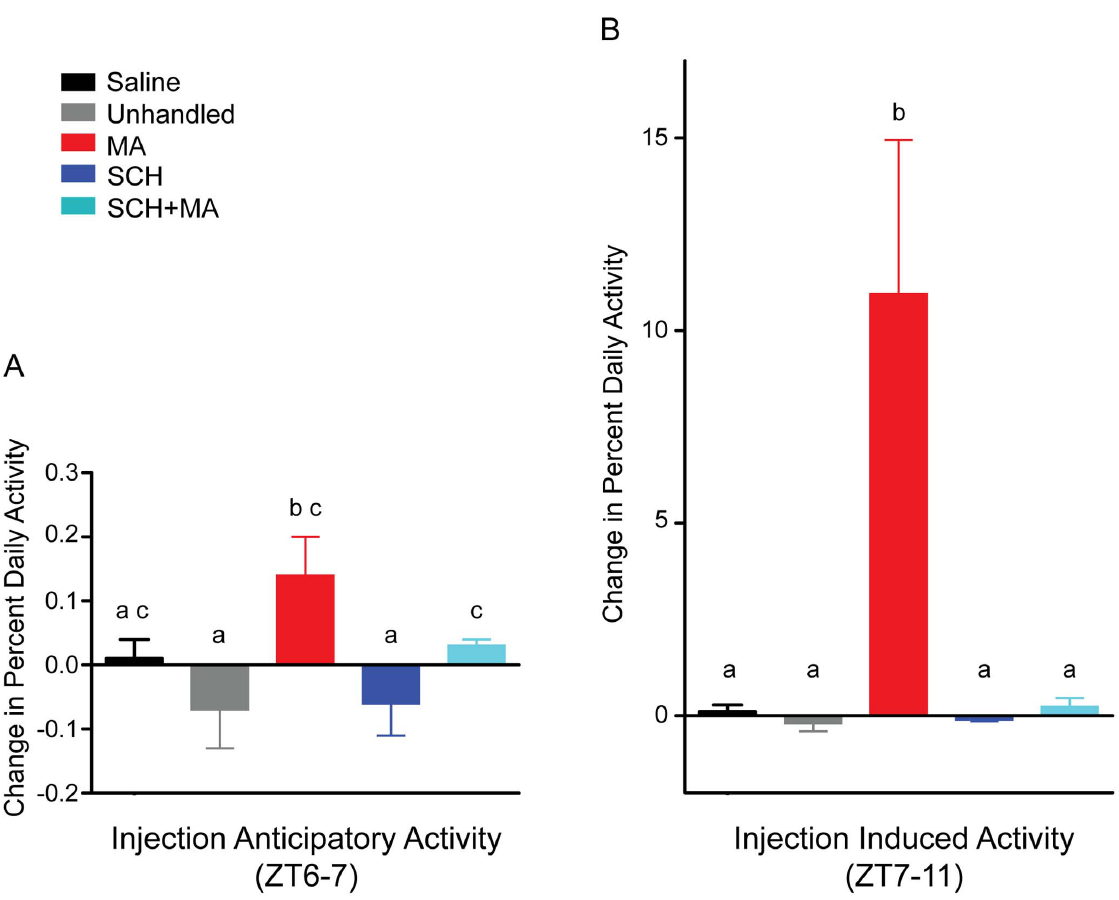
Figure 3. Scheduled daily MA injections result in anticipatory and induced activity. A) Injection anticipatory activity. For each mouse, activity level from ZT6-7 (1h prior to injection) was scored (as percent of average daily activity) on the last 7 days of injection and compared to that animal’s activity level from ZT6-7 on 4 days prior to the start of the injection paradigm (ZT6-7 corresponds to the area to the left of the pink vertical bar in Fig. 2B, D). The difference in activity levels are presented as mean 6 SEM. Different letters above bars represent significant differences ( p , 0.05) between groups (i.e., ‘‘a c’’ differs from ‘‘b c’’ but not from bars designated as ‘‘a’’ or ‘‘c’’ alone, ‘‘b’’ differs from ‘‘a c’’ and ‘‘a,’’ ‘‘c’’ differs from bars labeled ‘‘a’’ alone). B) Injection induced activity. For each mouse, activity level from ZT7-11 (4h post injection) was scored (as percent of average daily activity) on the last 7 days of injection and compared to the activity level from ZT7-11 on 4 days prior to the start of the injection paradigm (ZT7-11 corresponds to the area to the right of the pink vertical bar in Fig. 2B, D). The difference in activity levels are presented as mean 6 SEM. Different letters above bars represent significant differences ( p , 0.05).